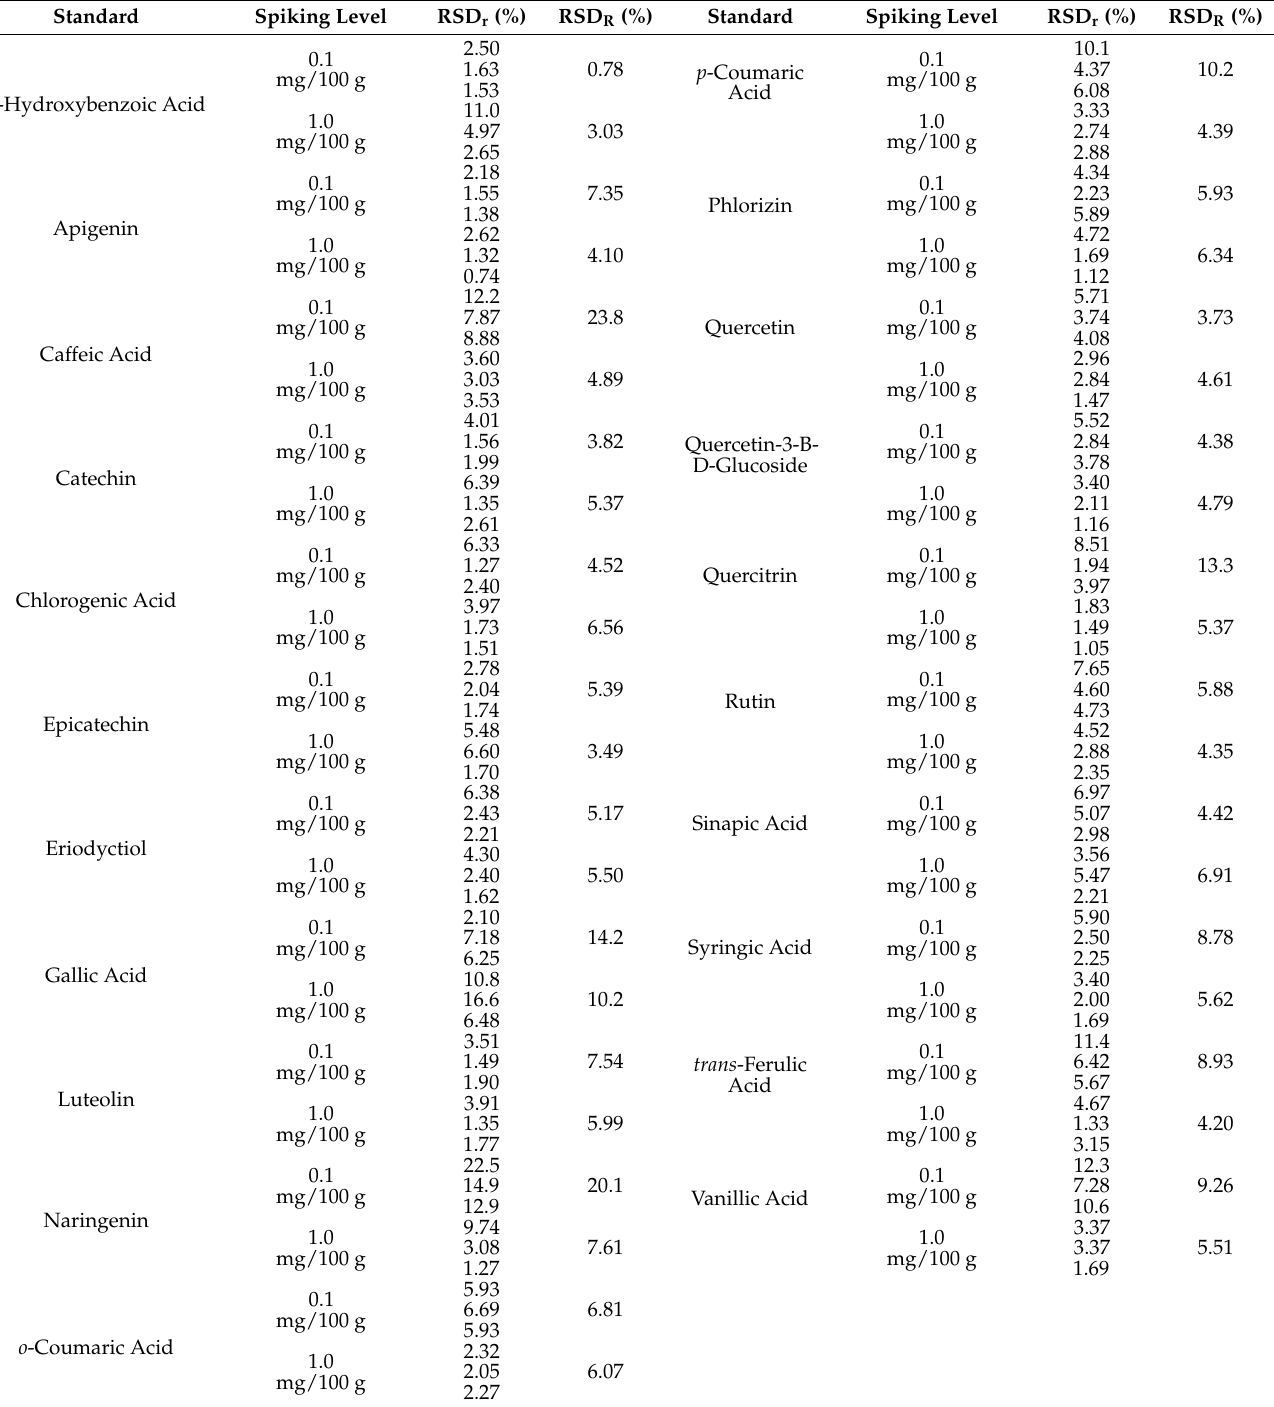
Table 8. Results of the relative standard deviation repeatability (RSD r ) and relative standard deviation of inter-day precision (RSD R ) at different spiking